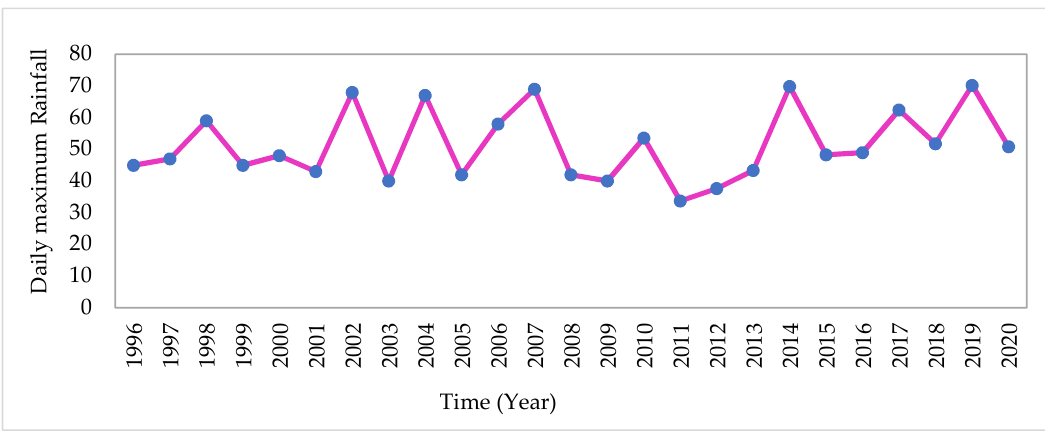
Figure 5. Daily maximum rainfall depth (mm) from 1996 to 2020 for Hawassa city.